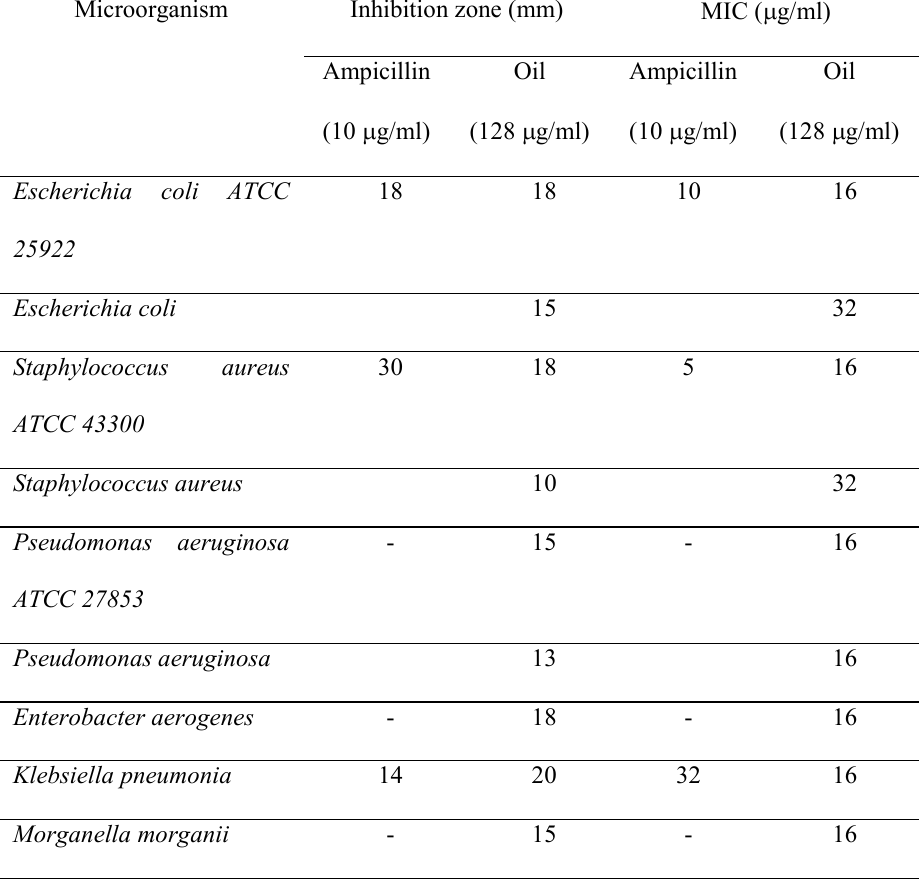
Table 2. Antibacterial activity of the essential oil of Athamanta sicula L.